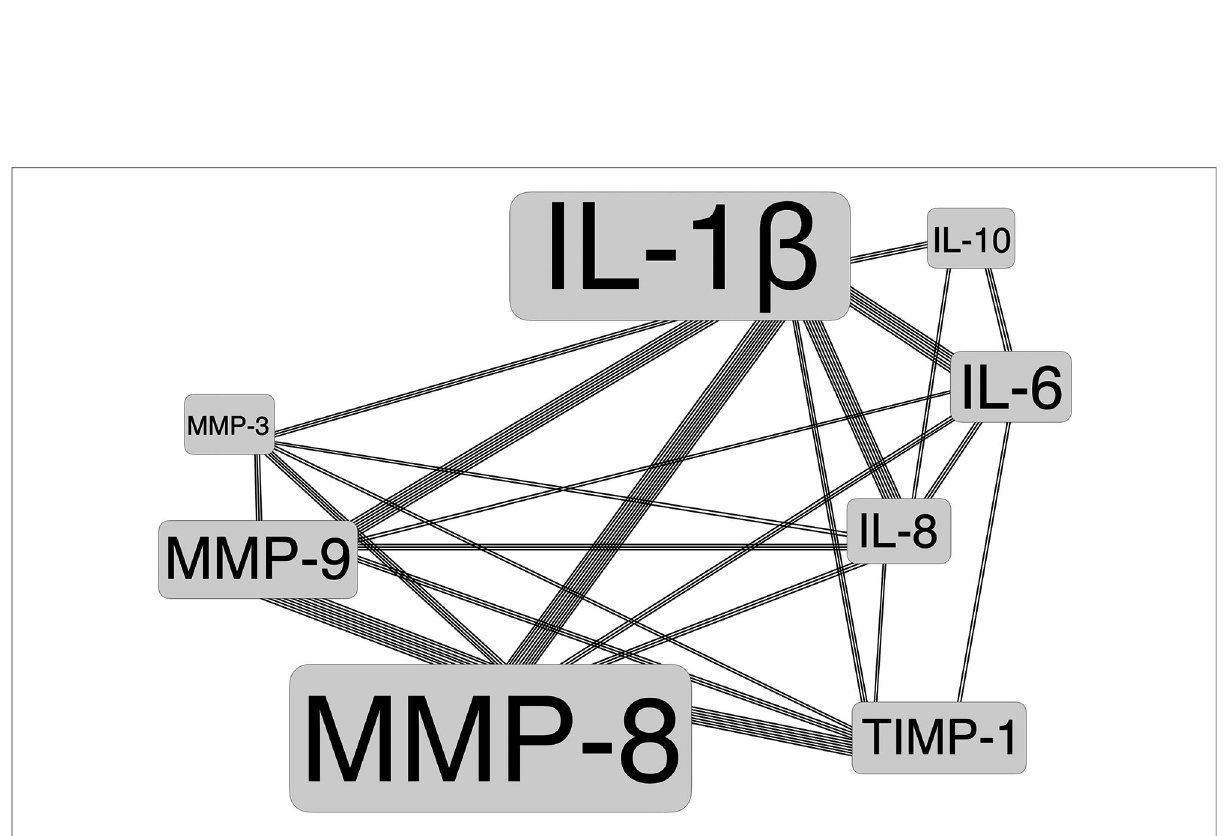
FIGURE 3 Major salivary biomarkers with frequency of occurrence (as illustrated by font size) and their combinations among